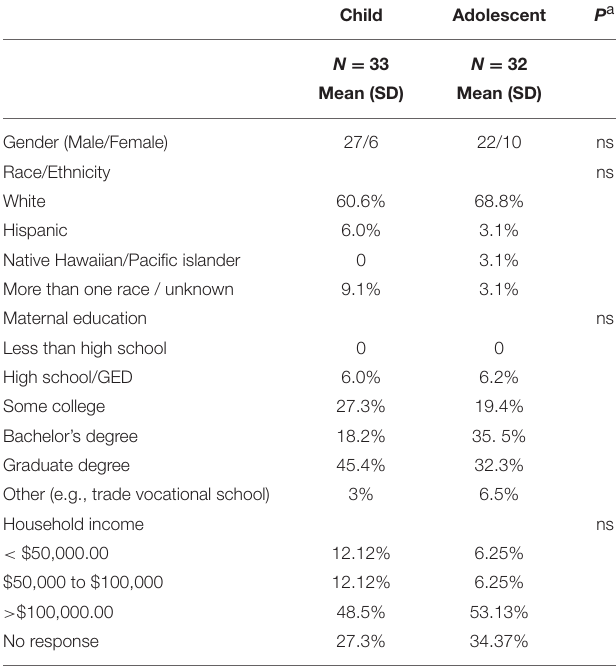
TABLE 1B | Demographic characteristics of the